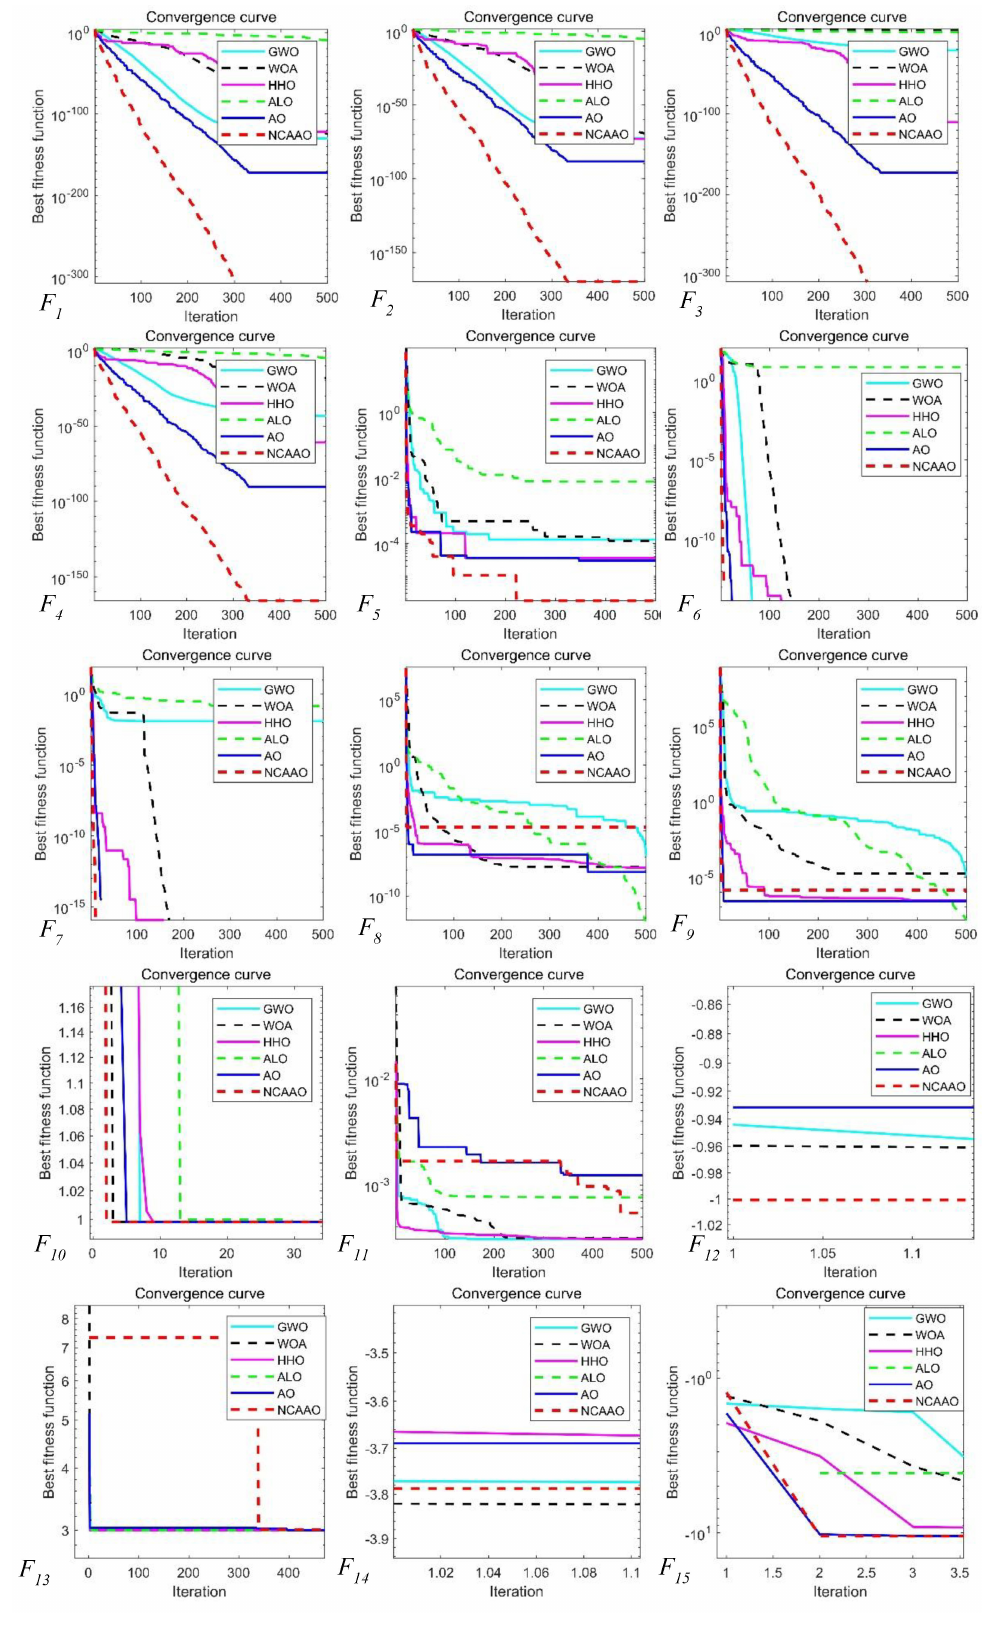
Figure 6. Convergence comparison curves of